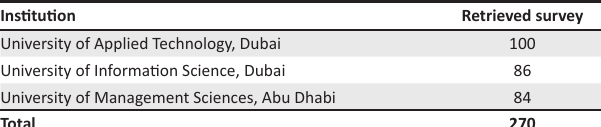
TABLE 1a: Background of respondents.